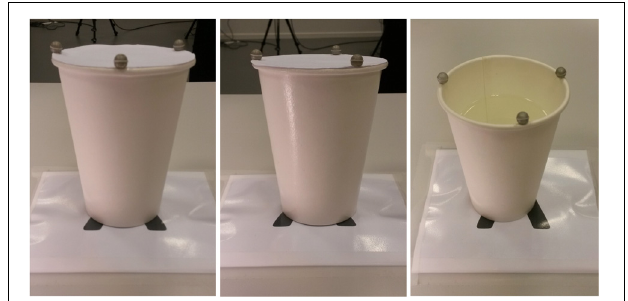
FIGURE 1 | Examples of the experimental stimuli: matte stimulus with hidden content (left) , shiny stimulus with hidden content (center) , and matte stimulus with visible content (right) .